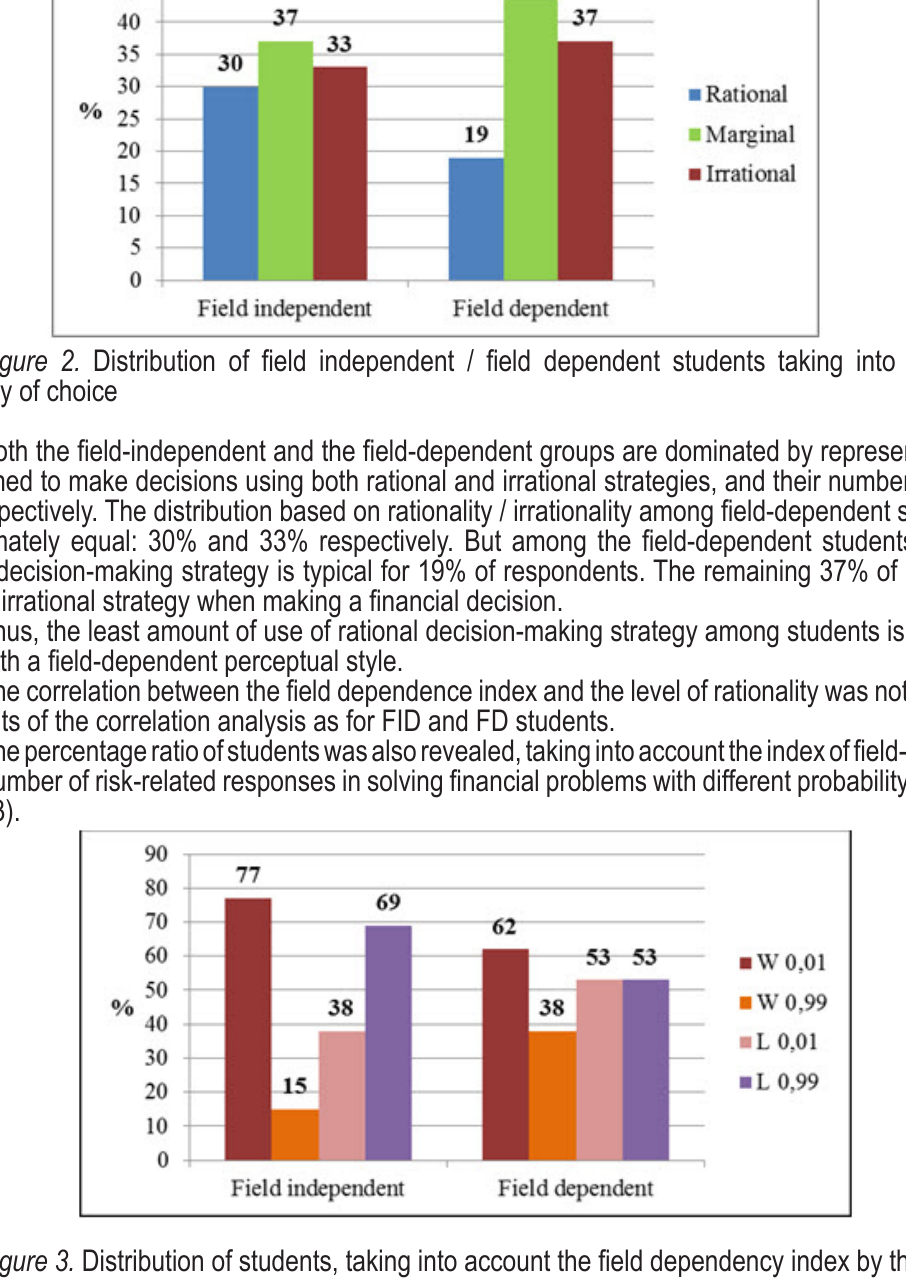
Figure 3. Distribution of students, taking into account the field dependency index by the number of risky